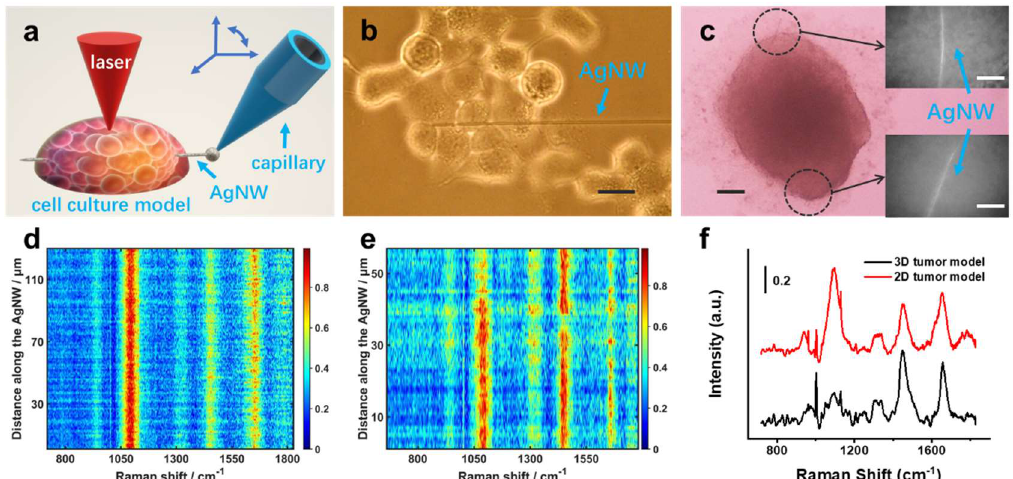
Figure 2. ( a ) Schematic diagram for inserting single AgNW into a cell culture model. ( b , c ) Optical images of a 2D model inserted with an AgNW ( b ) and a 3D model inserted with two AgNWs ( c ). ( d , e ) Contour graphs of Raman spectra along AgNW. ( d ) A 2D model with 130 spectra, and ( e ) a 3D model with 57 spectra.( f ) Average spectra of 2D and 3D models. The number of spectra used for the average spectrum calculation were 270 (2D) and 200 (3D), respectively. Scale bars: ( b ) 20 μm; ( c ) 100 μm and ( c ) inset 30 μm. Table 1. Tentative assignments of important bands in the Raman spectra of 2D and 3D models [19,20,25]. Bands (2D) [cm − 1